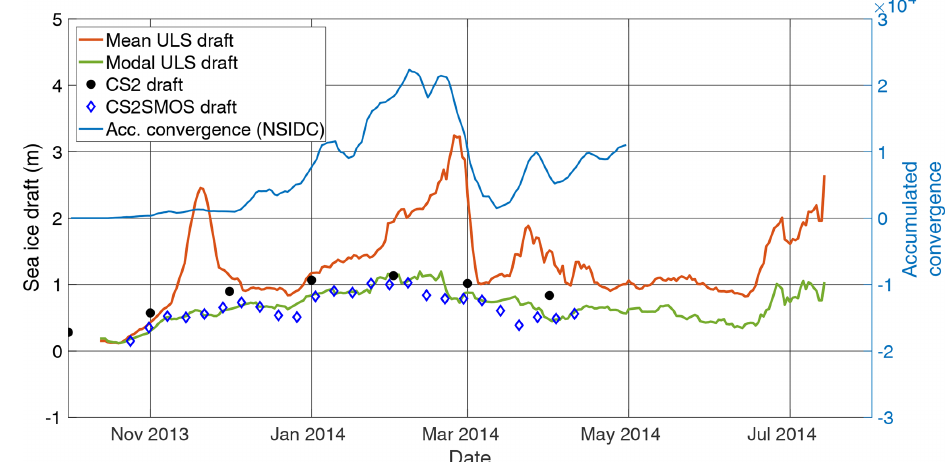
Figure 7. Time series of CS2 (black circles) and CS2SMOS (blue diamonds) sea ice draft compared to ULS-derived mean (orange) and modal (green) sea ice draft from Taymyr station (2013–2014). Sea ice passing the mooring site was tracked using the Lagrangian ice tracking tool ICETrack (Krumpen, 2017). Based on the NSIDC Polar Pathfinder sea ice motion product (Tschudi et al., 2019), accumulated convergence (blue) along the daily sea ice trajectories was calculated.